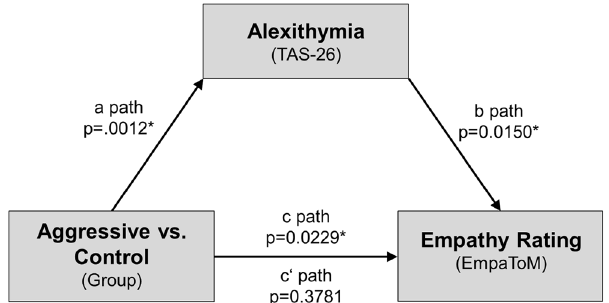
Figure 3. Mediation model for the effect of aggressive behaviour on empathic responses, alexithymia is modelled as